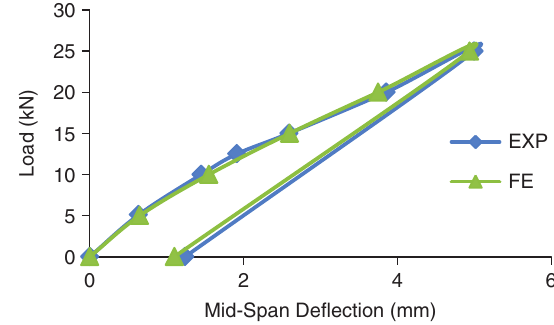
Fig. 9. Load against de fl ection curves for G1D (EXP refer to Experimental data and FE refer to Finite Element modelling data)